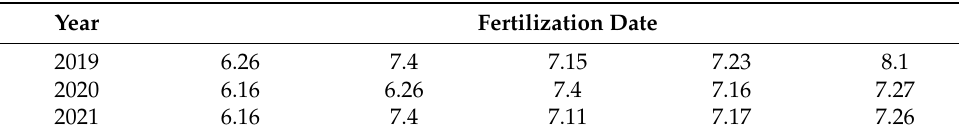
Table 2. Fertilization time from 2019 to